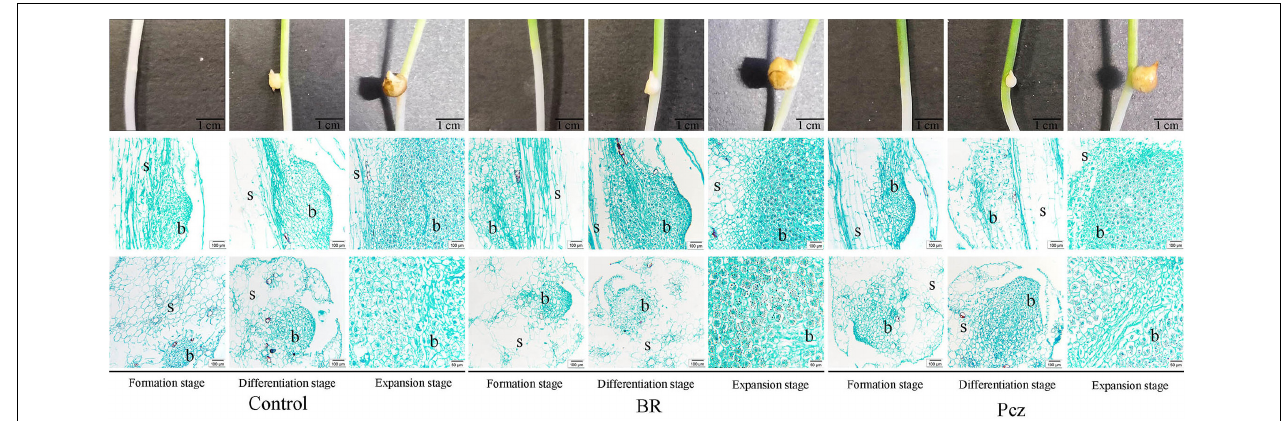
FIGURE 1 | Anatomical and histological structure of P. ternata during bulbil formation and development. Scale bar for samples images = 1 cm; Scale bar for microscopy images = 100 or 50 µ m. s, stem; b, bulbil.